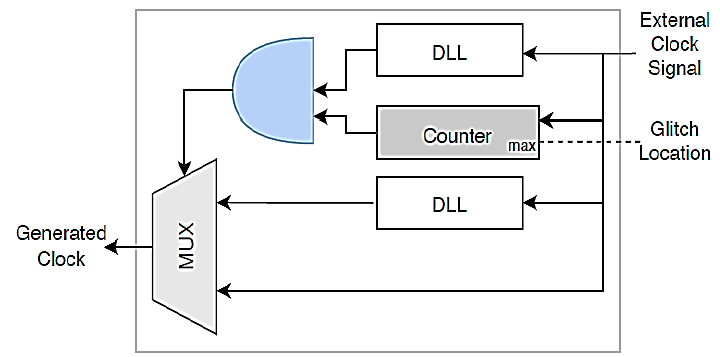
Figure 12. Glitch generator based on divider and FPGA’s DLL (delayed locked loop) [40].